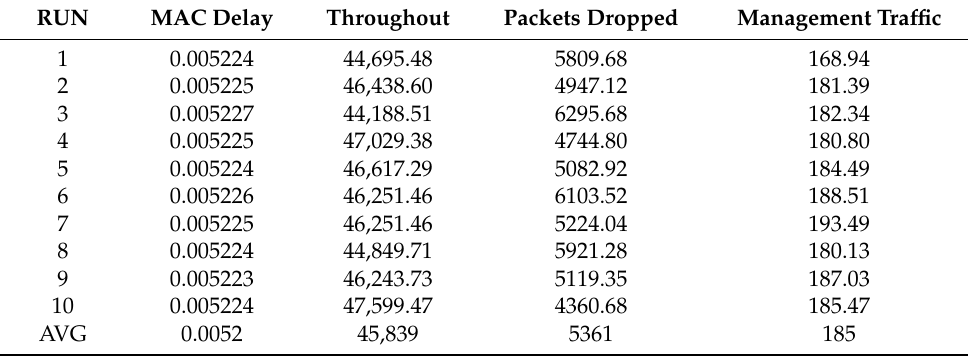
Table 20. Fire Station Scenario